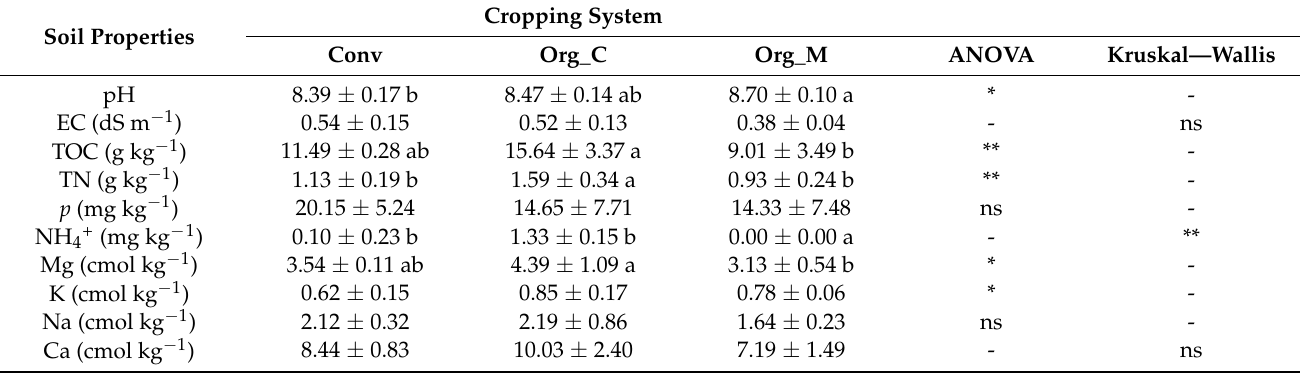
Table 3. Soil properties in the three cropping